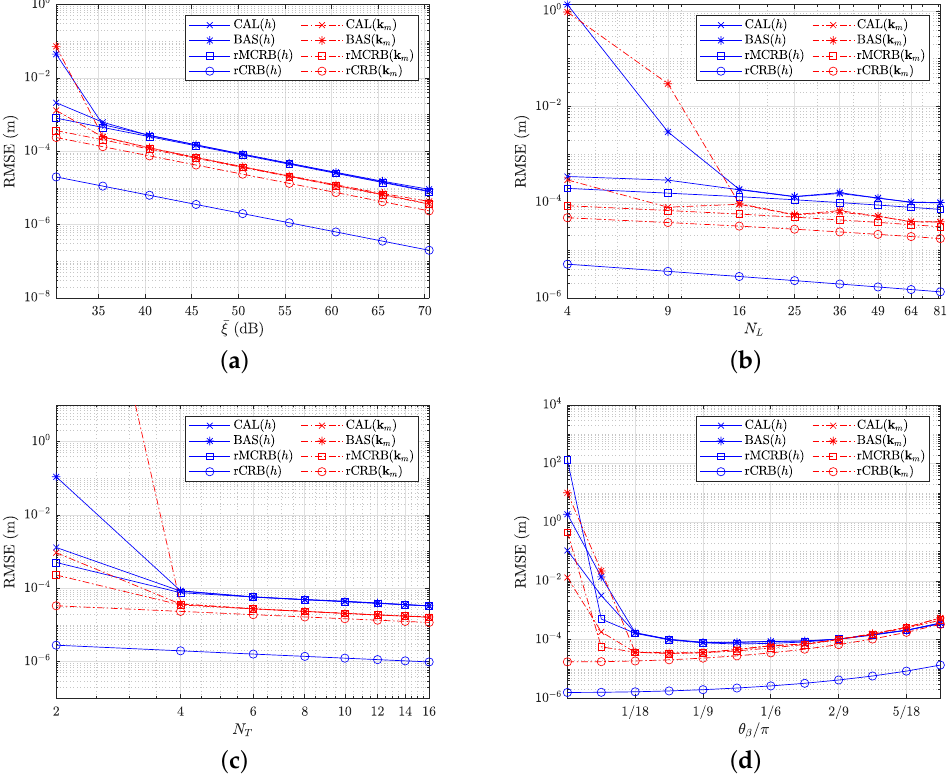
Figure 5. RMSE of the estimator and the theoretical bound: ( a ) N L = 25, N T = 4, θ β = π /9 rad; ( b ) SNR = 45 dB, N T = 3, θ β = π /9 rad; ( c ) SNR = 45 dB, N L = 25, θ β = π /9 rad; ( d ) SNR = 45 dB, N L = 25, N T =